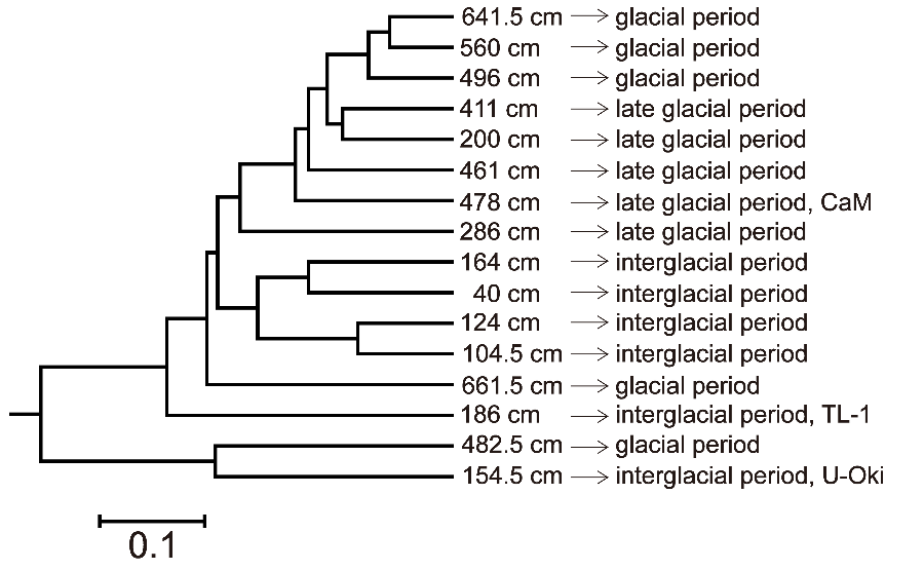
Figure 8. Cladogram of Samples Based on the Analytical Data of the Weighted UniFrac Distance. Tree was constructed from 16 samples. Below the scale bar indicates 0.1% sequence divergence.